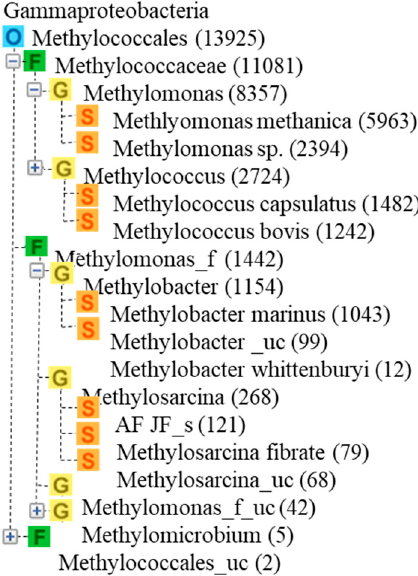
Figure 1. Composition of methanotroph species (output from CL community (ChunLab Inc.) cultured in NMS medium. The numbers in parentheses indicate the number of bacteria belonging to the particular species in the samples.